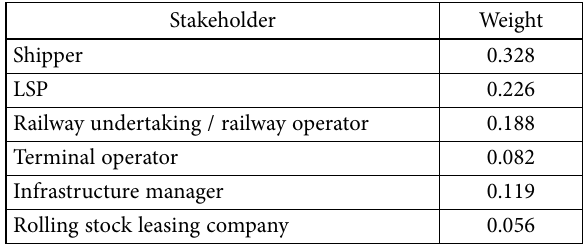
00.020.040.060.080.100.120.14 Figure 17. Absolute utilities of all effects or attributes expected by the stakeholders